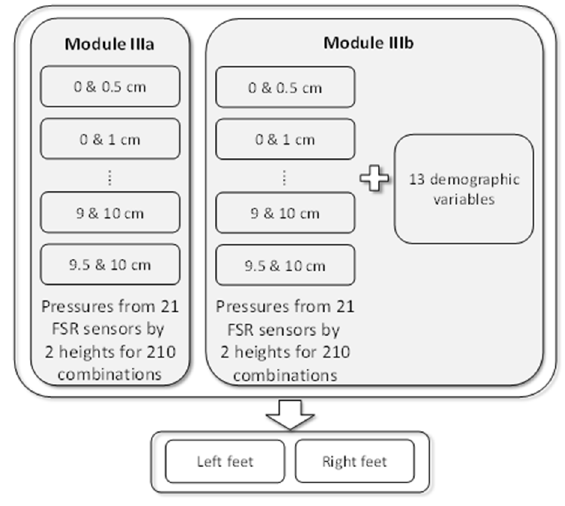
Figure 6. Models in Module II.